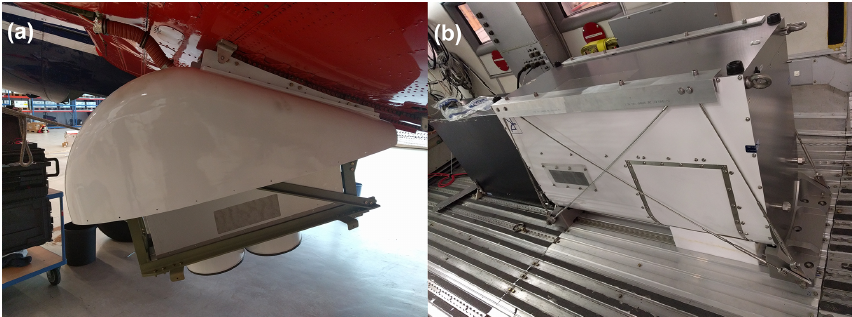
Figure 3. (a) MiRAC-A with opened belly pod below the research aircraft Polar 5. (b) MiRAC-P eight-channel radiometer mounted in the aircraft cabin.